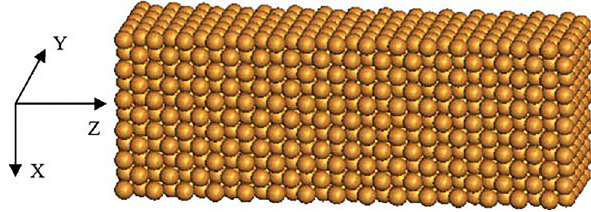
Figure 11: Simulation model of Cu nanowire [63]